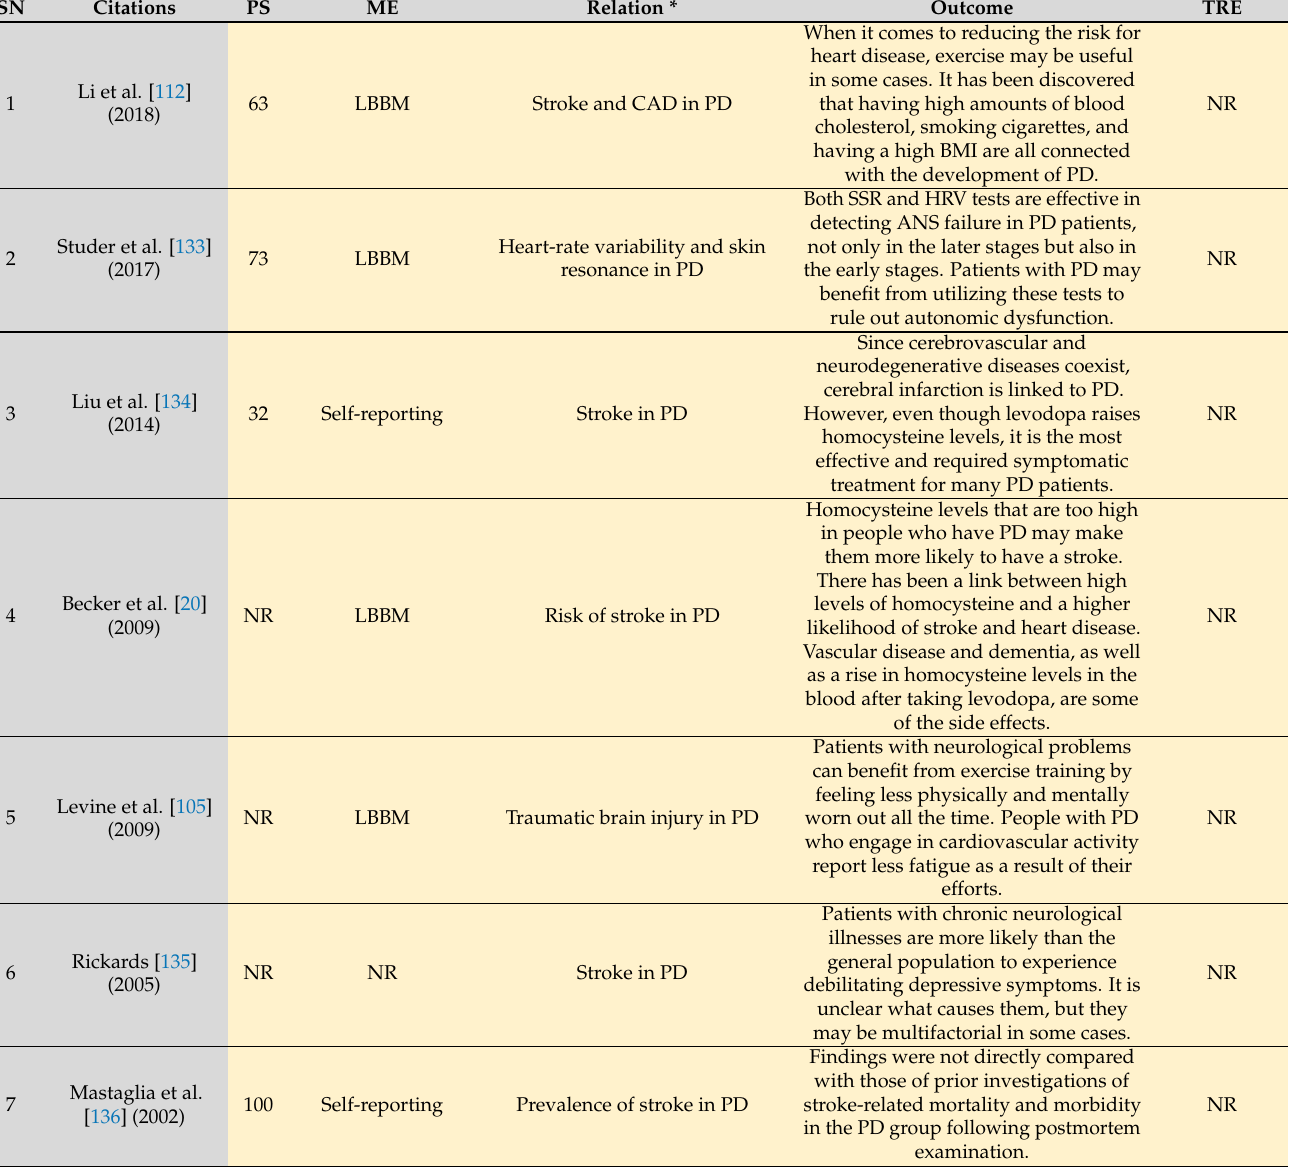
Table 2. Parkinson’s disease leading to stroke without